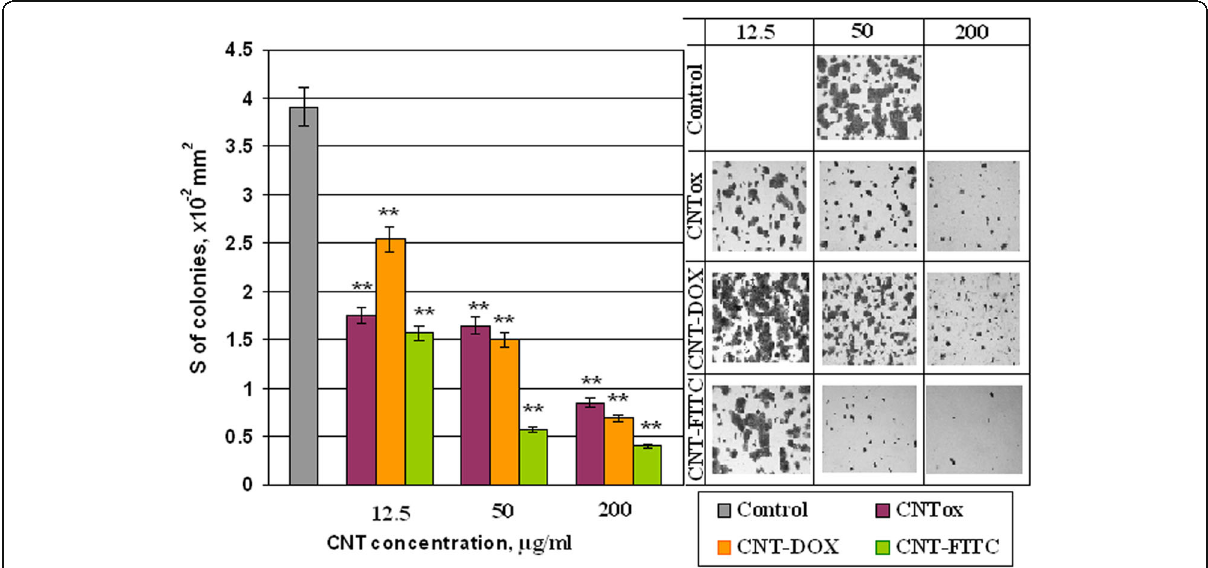
Fig. 6 The area of colonies of HT29 tumor cells in monolayer culture which was incubated with CNTox (# 1), CNT-Dox (# 3), CNT-FITC (# 5). Statistical significance: * р ≤ 0.05 or ** р ≤